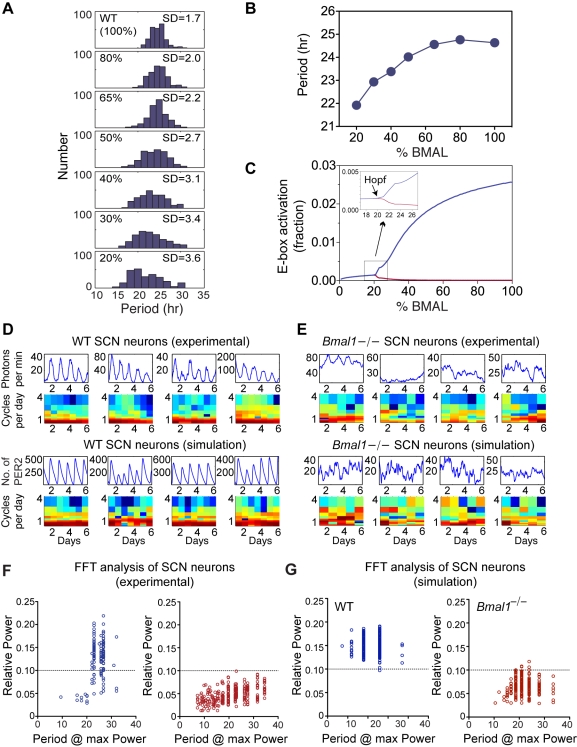
Effects of BMAL activator level on circadian oscillations in a stochastic model of isolated cellular oscillators.(A) Histograms of simulated isolated cell mean period lengths at various percentages of total WT BMAL. These results show that as the percentage of total BMAL decreases, the mean period length decreases, along with an increase in the variance of the period. (B) The figure shows that as we go below certain percentage of total BMAL, rhythms in a population of uncoupled single cells disappear. This figure is an alternative way to observe bifurcations by plotting the period from a population of single un-coupled cells as a function of total BMAL. Below ∼20% of total BMAL, rhythms disappear in single cells, indicating a Hopf bifurcation at this point. (C) The bifurcation diagram of a single oscillator as a function of total BMAL using a deterministic model. The y-axis plots the value G, which mathematically represents the fraction of time an E-box is activated. This was chosen since this variable affects basically all parts of the model (in particular PER1, PER2 CRY1, CRY2, all their relevant complexes, and the coupling factor). In theory, any possible variable could be used for the bifurcation diagram and the same behavior (i.e., a Hopf bifurcation) would be observed. Plotted on this diagram are the minimum and maximum (red and blue, respectively) values from the oscillation of G at a particular value of total BMAL—100% BMAL corresponds to WT BMAL. When these values are equal, the system is at rest and no oscillations are present; however, as these values begin to diverge, oscillations are observed. At approximately 22% of total BMAL, we begin to observe oscillations, indicating that a Hopf bifurcation exists at this point (see inset). Therefore, single cells show no sustained rhythmic behavior below ∼22% of total BMAL. (D) Representative traces of PER2::LUC bioluminescence measured experimentally in WT isolated SCN neurons and their respective FFT spectrograms are shown in the top row. Representative traces of WT simulated isolated cells and their respective FFT spectrograms are shown in the bottom row. (E) Representative traces and their respective FFT spectrograms of Bmal1
−/− experimental (first two rows) and simulated isolated cells (bottom rows). These results show a loss of circadian rhythms in single Bmal1
−/− SCN cells in both experimental and simulated isolated cells. (F) FFT spectral analysis for PER2::LUC rhythms recorded from dissociated SCN neurons. A cell was considered to show significant circadian periodicity when spectral analysis indicated a peak in the circadian range (20–36 h) large enough such that a 0.14 cycles/day window centered on the peak accounted for at least 10% of the total variance in the record (FFT power spectrum, Blackman-Harris windowing, peak amplitude ≥0.1) as described previously [40]. All (243 of 243) Bmal1
−/− cells were equal to or below a 0.1 cutoff value for circadian rhythmicity (indicated by the dotted line), whereas approximately 80% of WT neurons were above this cutoff value and displayed circadian rhythmicity. (G) FFT spectral analysis on simulated PER2::LUC rhythms from isolated SCN neurons. A cell was considered to show significant circadian periodicity using the same criterion as in (F). All but two (248 of 250) WT cells were above the 0.1 cutoff value (indicated by the dotted line) for circadian rhythmicity. Only 5 of 250 simulated Bmal1
−/− neurons were equal to or above this cutoff value.